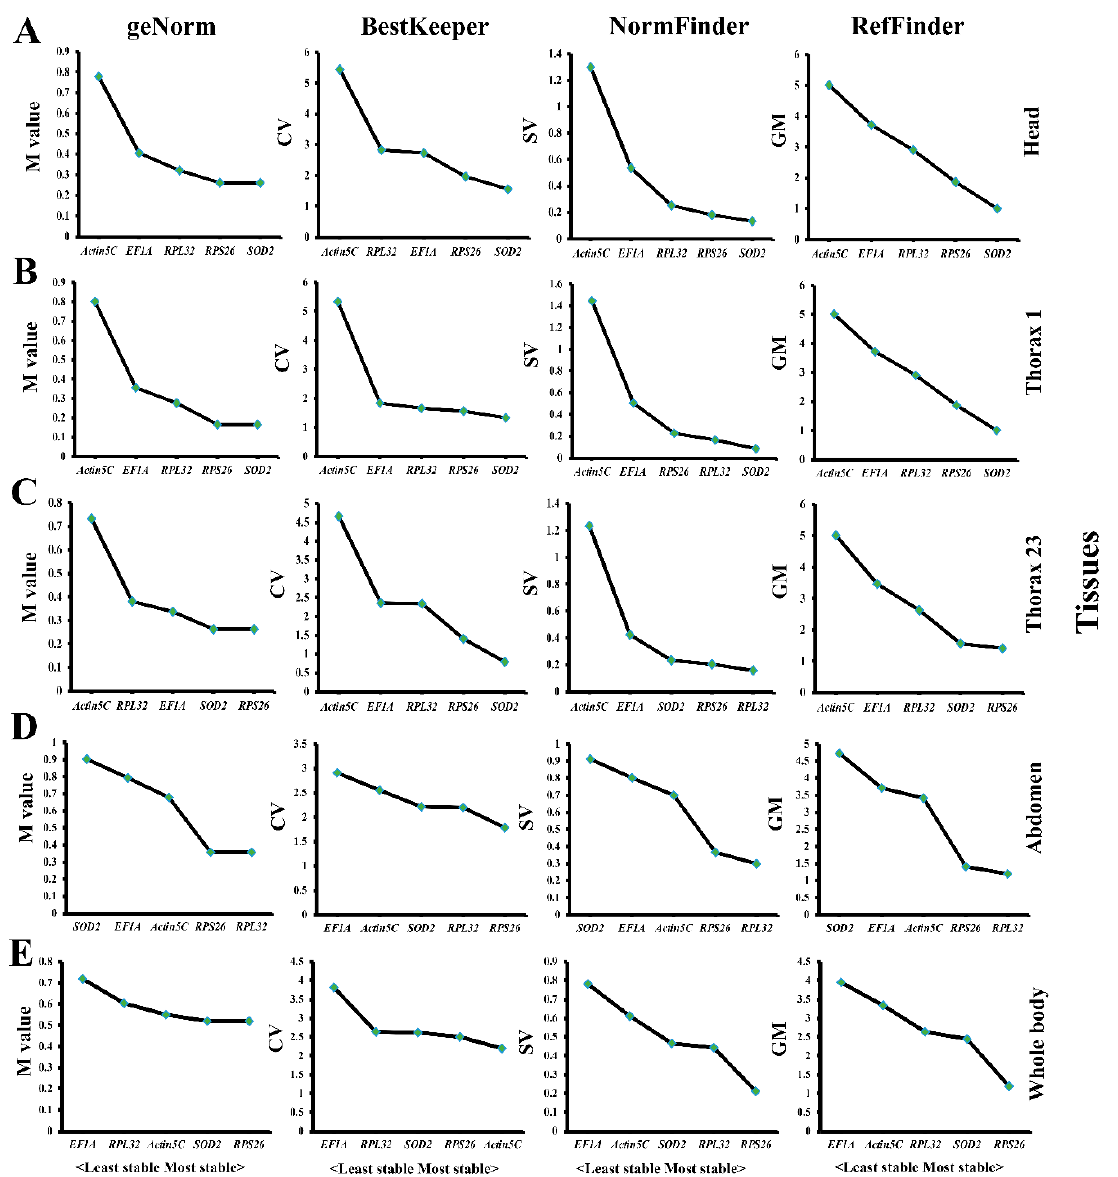
Figure 3. Stable analysis of five candidate genes at different developmental stages from nymphs (N6–N9) and adults (A1, A3, and A4) of Thermobia domestica in different tissues: head ( A ), prothorax ( B ), mesothorax/metathorax ( C ), abdomen ( D ), and whole body ( E ) based on four algorithms.